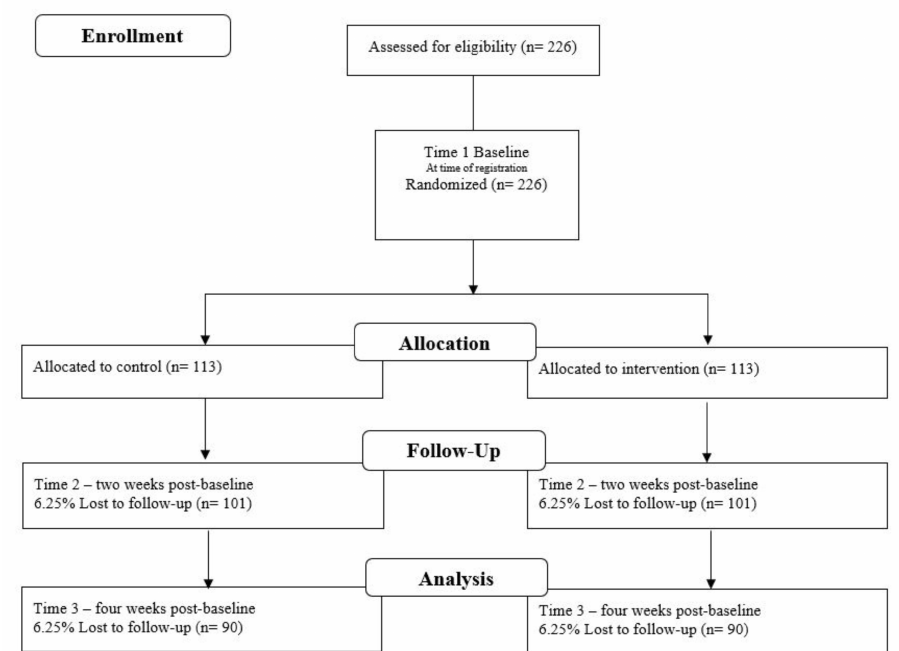
Figure 1. Flow of Participants Through the